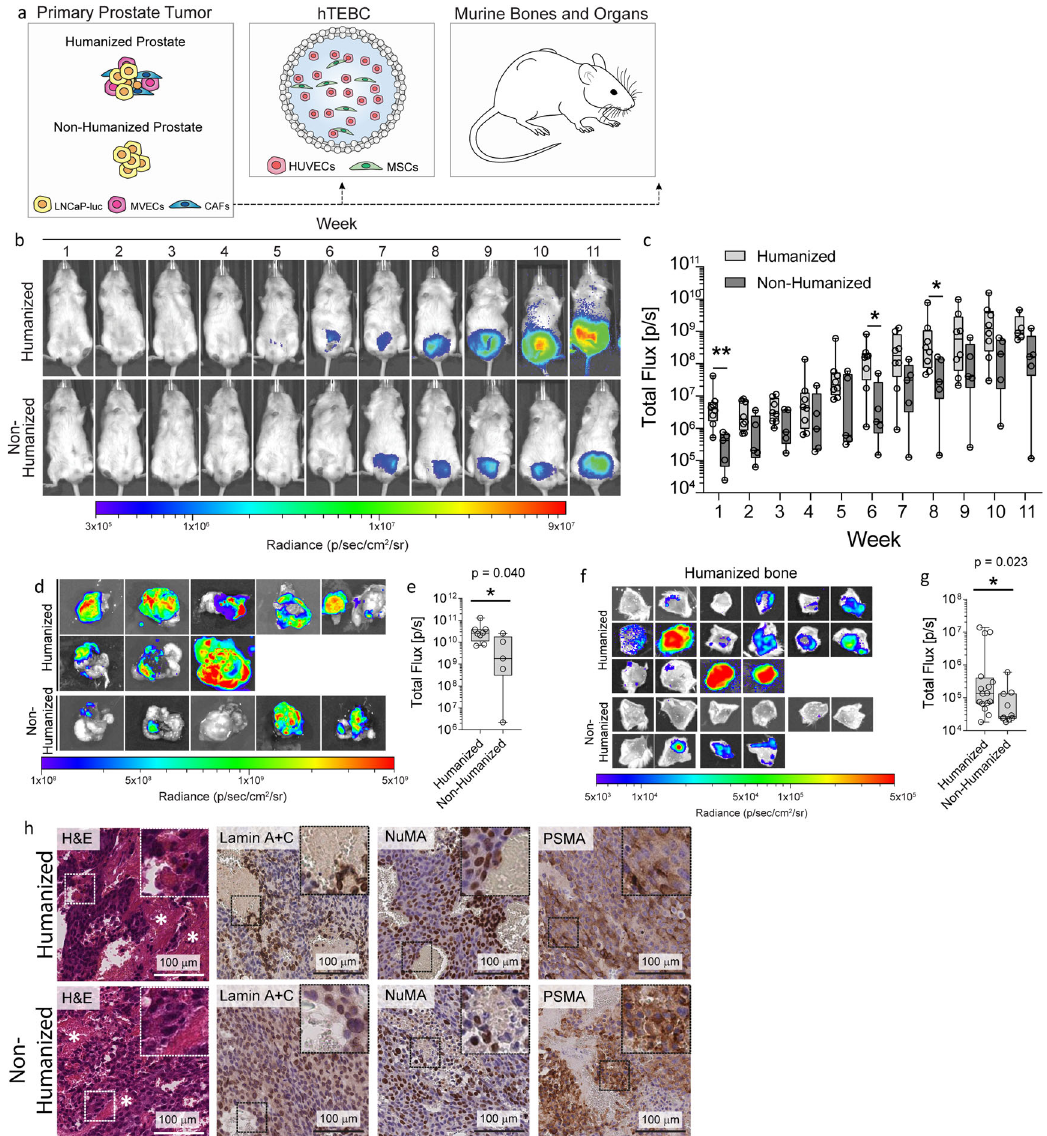
Fig. 4 Growth of LNCaP-luc primary prostate tumors and metastasis from the primary prostate tumor to the hTEBC. a Overview of the different levels of humanization within the in vivo model. The prostate was humanized by co-injection of LNCaP-luc, BVECs, and CAFs into the murine prostate. The back of the mice received humanized bone constructs with hOB seeded scaffolds. b Representative whole body in vivo bioluminescent images (BLI) over the 11 weeks following intraprostatic injection. c Quanti fi cation of in vivo BLI signal in mice with the humanized (light gray box plots) compared to the non- humanized (dark gray box plots) prostate microenvironment ( n = 5 mice in the non-humanized prostate group and n = 8 mice in the humanized prostate group). d Ex vivo BLI images of murine prostates and e correlating quanti fi cation of ex vivo BLI signal from the mouse prostates at the experimental endpoint ( n = 5 in the non-humanized prostate group and n = 8 prostates in the humanized prostate group) reveals that there was a signi fi cant difference between the groups. f Representative ex vivo BLI of the hTEBCs with LNCaP-luc PCa metastases and h quanti fi cation of the BLI data from LNCaP-luc cells which had metastasized from the primary prostate tumor to the hTEBC ( n = 10 scaffolds in the non-humanized prostate group and n = 16 scaffolds in the humanized prostate group) reveals increased LNCaP metastasis from the humanized prostate to the hTEBC. g Hematoxylin and eosin (H&E) staining of the primary tumor. Immunohistochemistry staining for NuMA and Lamin A + C using antibodies that react with human but not murine tissues were performed. Prostate-speci fi c membrane antigen (PSMA) immunohistochemistry was performed as an additional marker for human LNCaP cells. The scale bars represent 100 µ m. Data are represented as box plots depicting the median, fi rst and third quartile, minimum and maximum, and are overlaid with individual data points. All data were not normally distributed and were analyzed using a Mann − Whitney U test. The mouse schematic image was sourced from Wikimedia Commons 52